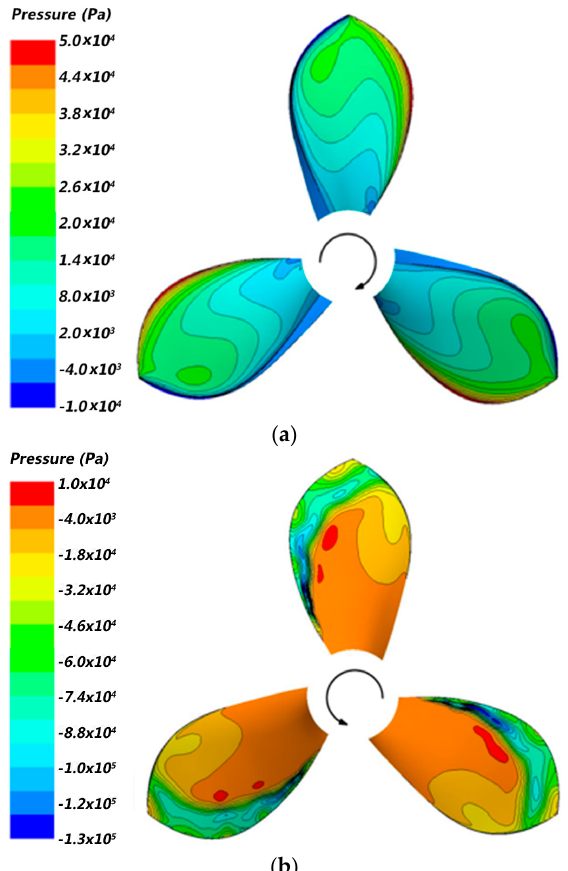
Figure 7. The pressure distribution on the blades at J = 0.85 under unventilated condition. ( a ) The pressure distribution on the pressure surface; ( b ) The pressure distribution on the suction surface.